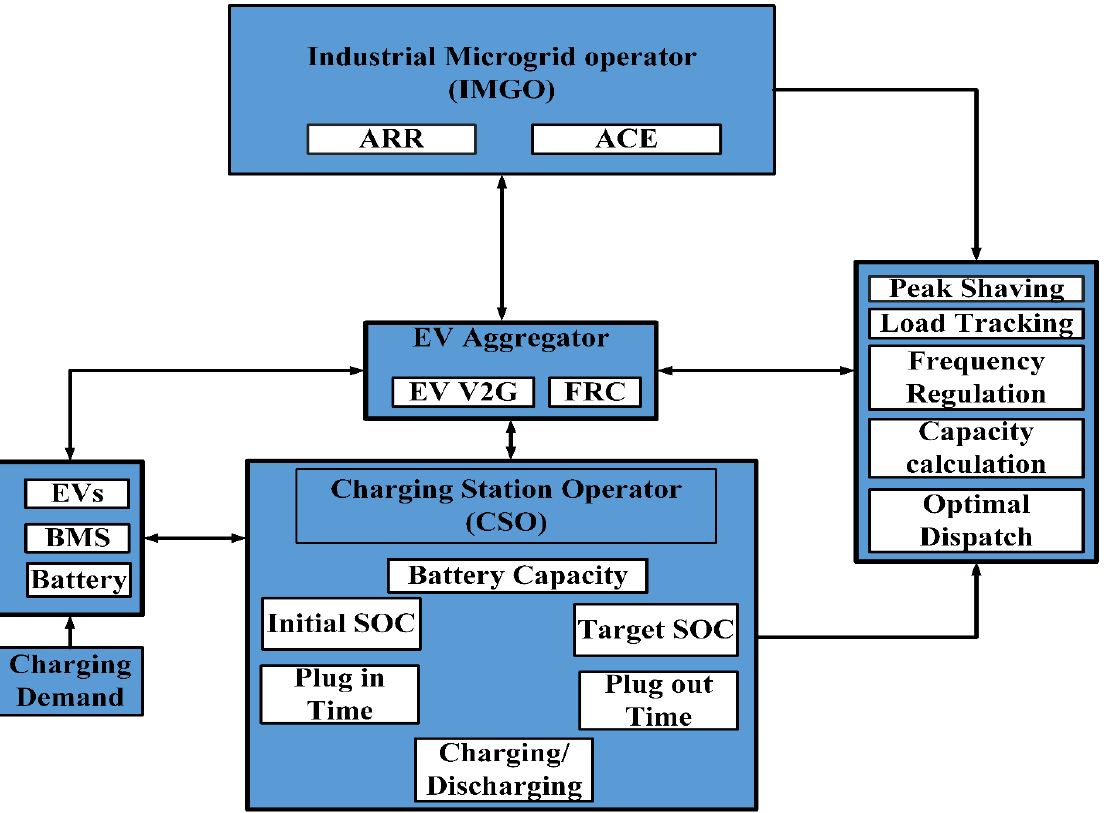
Figure 1. Conceptual view of the vehicle to grid (V2G) strategy.